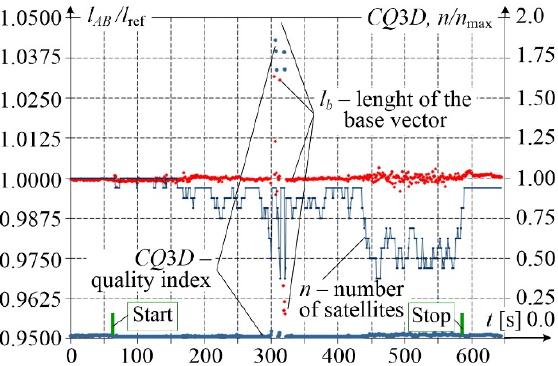
Figure 5. Variability of the relative length of measuring base vector, number of available satellites, and quality index.